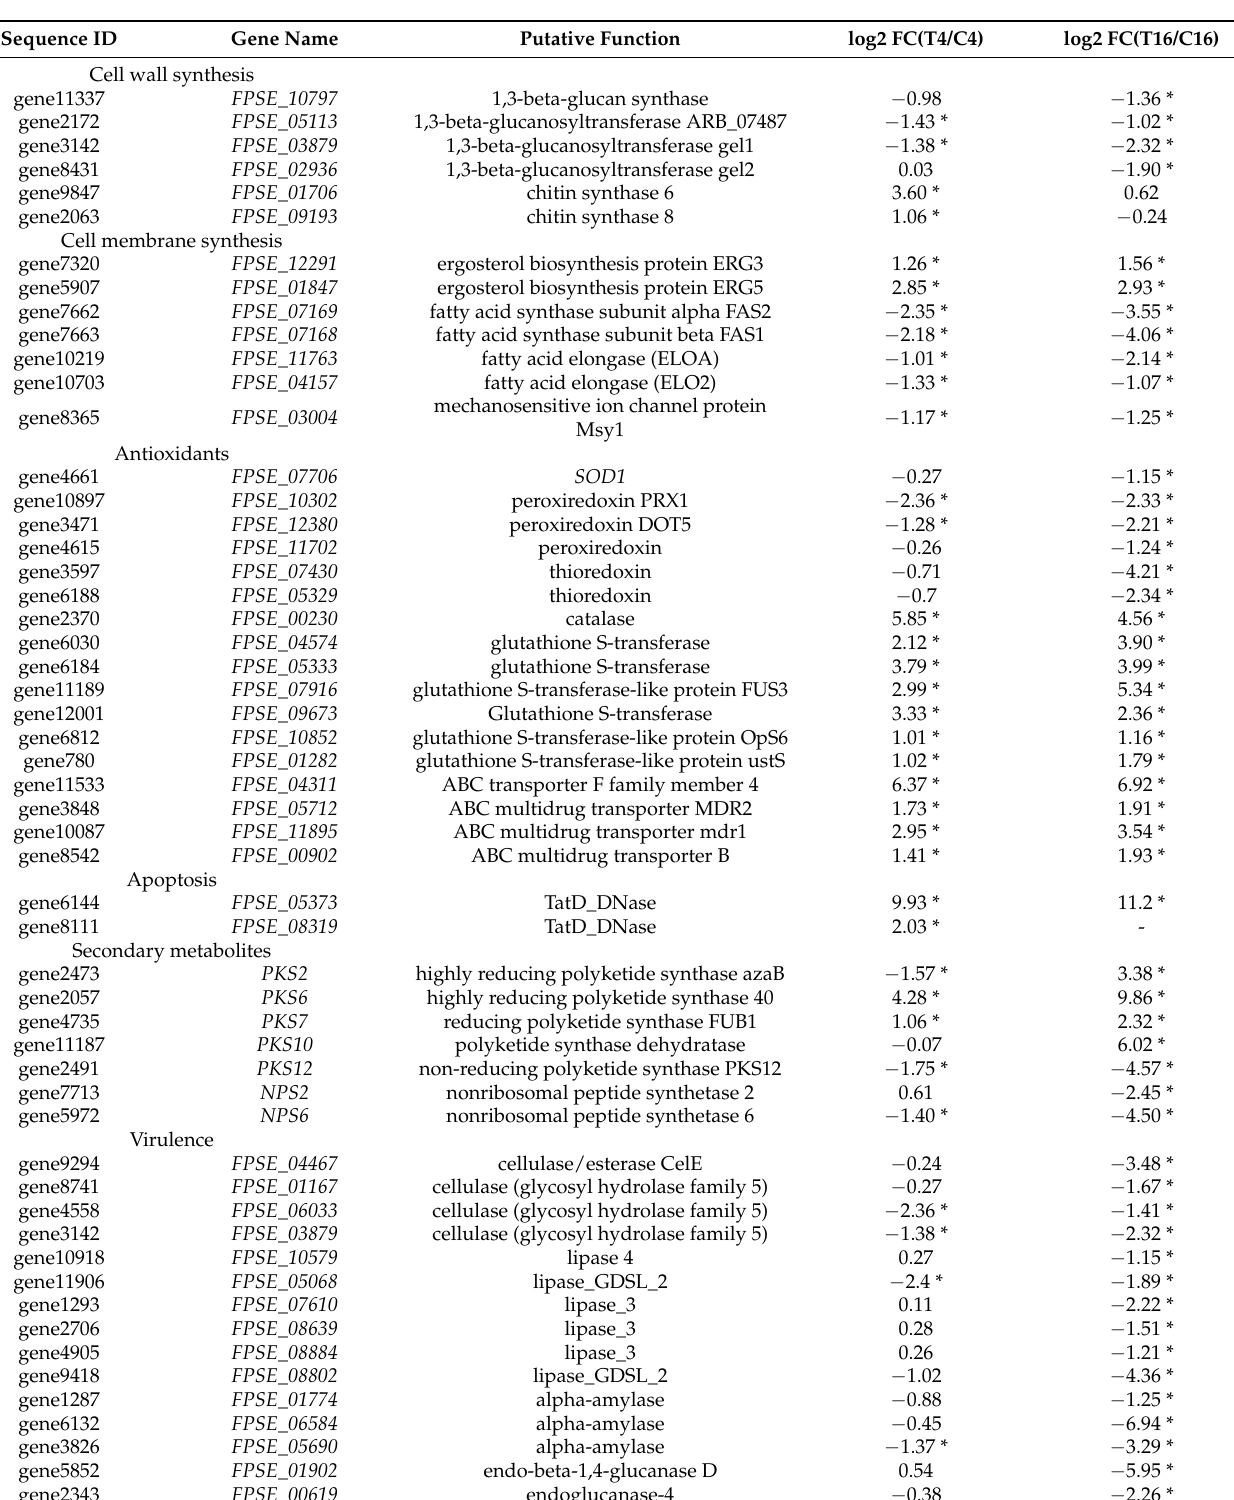
Table 1. Fold changes in F. pseudograminearum differently expressed genes (DEGs) between pure cultures and co-cultures with YB-185 at 4 h and 16 h cultivation. Sequence ID is the assembled unigene; gene name is from the mapped gene in the genome of Fusarium pseudograminearum CS3096; and putative function from the Pfam, Swiss-Prot, and COG databases. C4 and T4 samples are RNAs of F. pseudograminearum cultured for 4 h without or with YB-185, respectively, and C16 and T16 samples are RNAs of F. pseudograminearum cultured for 16 h without or with YB-185,